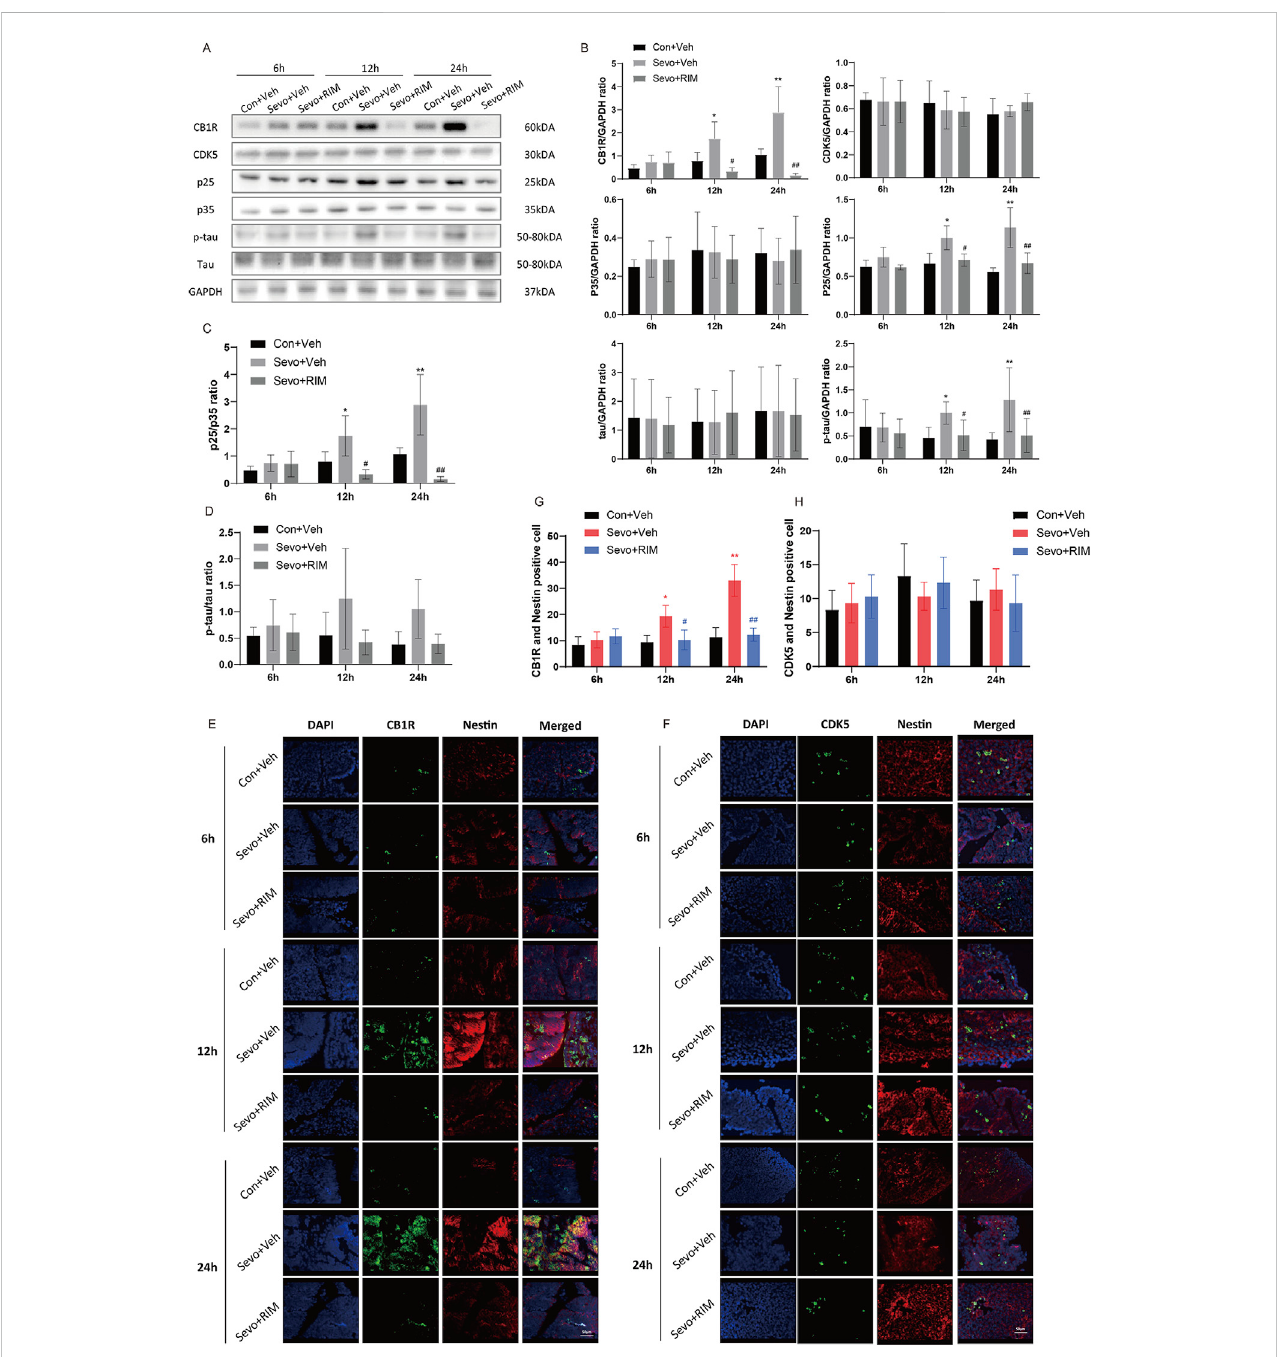
FIGURE 4 Sevo fl urane upregulated p-tau in the fetal brains via the CB1R/CDK5/p25 pathway. Assays of western blotting ( n = 3) demonstrating the expression of CB1R,CDK5, p35,p25, tau,and p-tau (A,B) and thevalueofp25/p35 (C) andp-tau/tau (D) .Immuno fl uorescence double staining ofCB1R and Nestin( E , n =3) and CDK5 and Nestin ( F , n = 3) in the fetal rat brains. Quanti fi cation of CB1R/Nestin-positive cells (G) and CDK5/Nestin-positive cells (H) . Data are manifested as mean ± S.E.M. * p < .05, ** p < .01, vs. the Con + Veh group; # p < .05, ## p < .01, vs. the Sevo + Veh